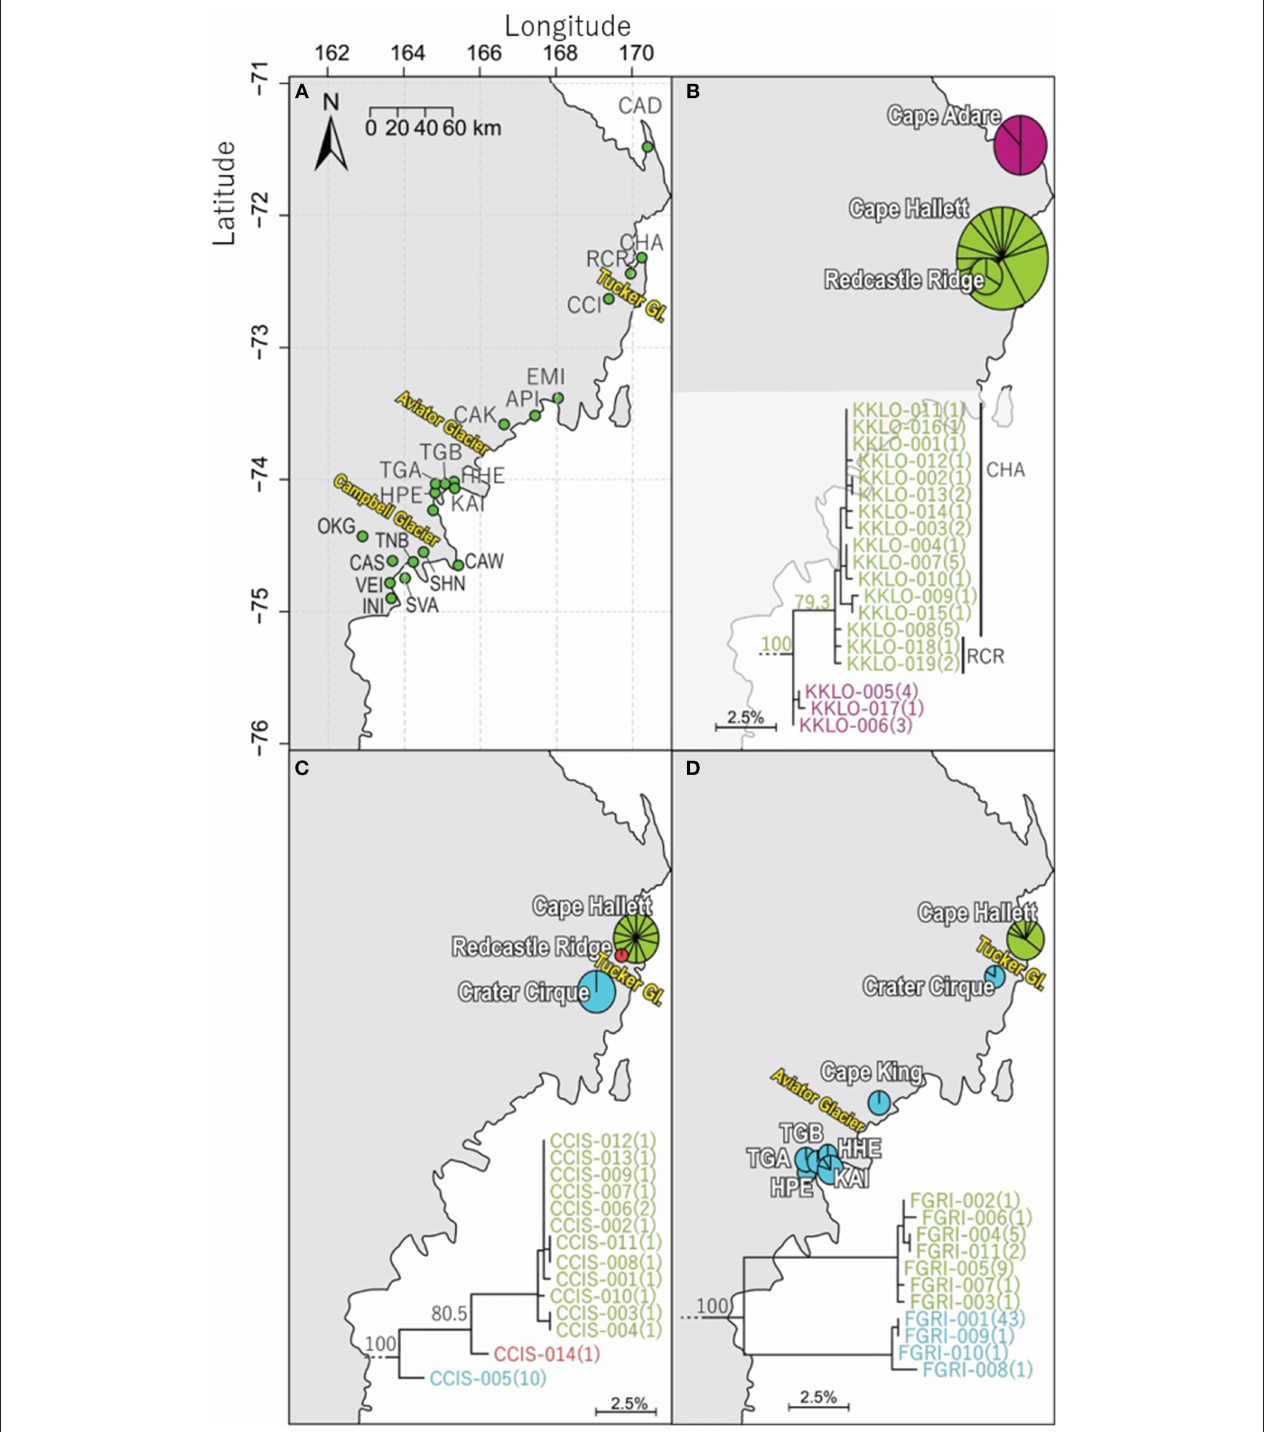
FIGURE 4 | Geographical distribution of COI sequences for three of the four springtail species within northern Victoria Land, with (A) an overview of collection sites and major glacial barriers, (B) geographical distribution of the 19 haplotypes of Kaylathalia klovstadi (KKLO; n = 35; 582 bp), (C) geographical distribution of the 14 haplotypes of Cryptopygus cisantarcticus (CCIS; n = 25; 567 bp), and (D) geographical distribution of the 11 haplotypes of Friesea grisea (FGRI; n = 66; 478 bp). Pie charts are proportionate to the number of sequences, centered at collection site co-ordinates. Tucker Glacier is a major barrier of dispersal for CCIS and FGRI, and no sequences of KKLO have been obtained from south of the Tucker